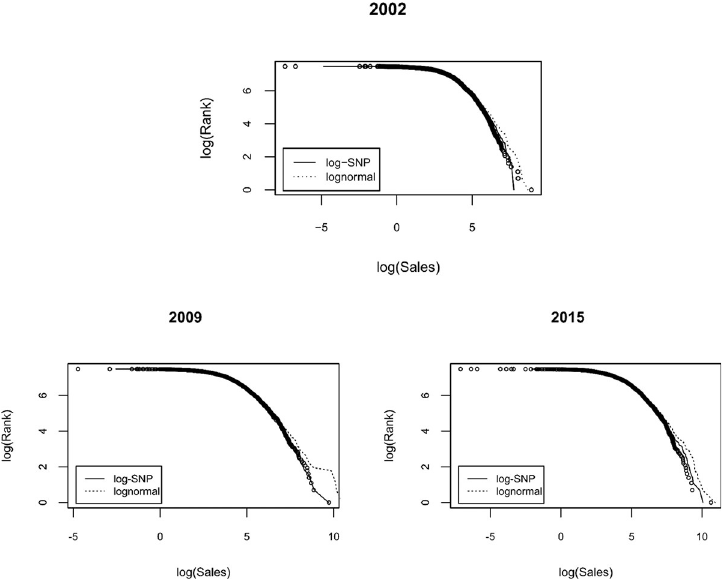
Fig 2. Logarithm of firm size vs. logarithm of sales. The figure compares the empirical values (hollow points) and the estimated values under a lognormal specification (dashed line) and log-SNP (solid line). The axes are in logarithmic scale and correspond to the relationship between Rank and Sales for a sample of 1,772 Colombian firms. Sales were divided by the factor 10 8 .